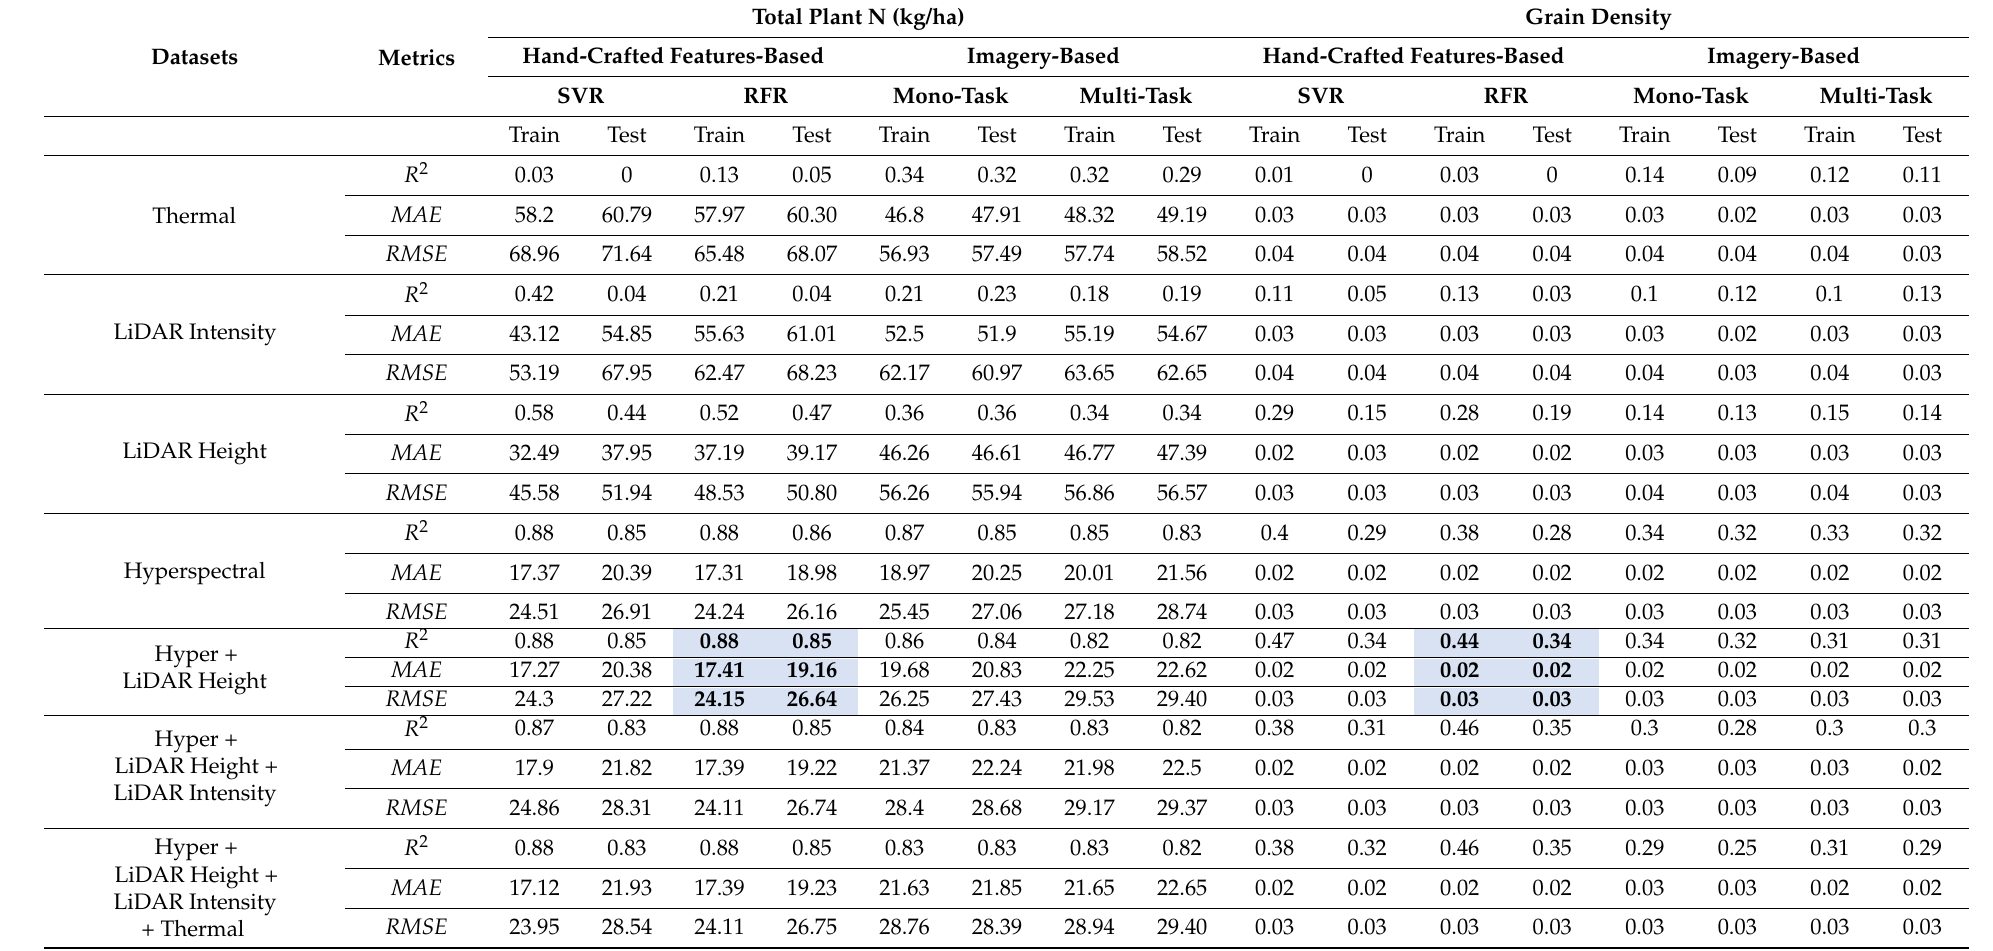
Table A3. Results of maize phenotypic prediction performed by different data sources and regressors